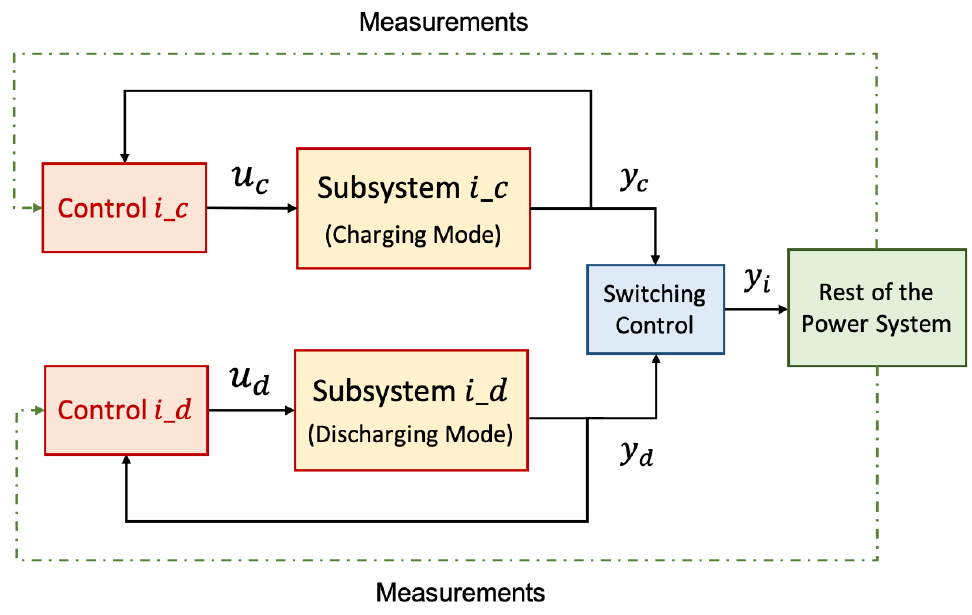
Figure 4. Hybrid control